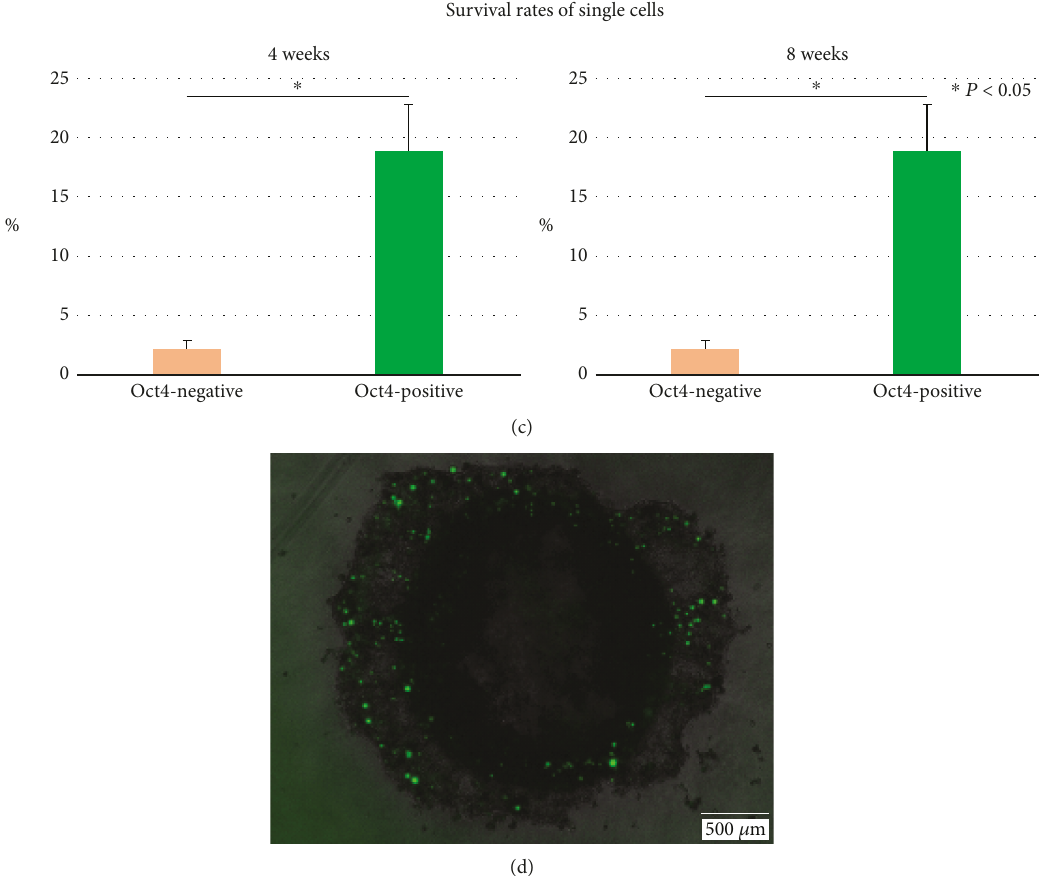
Figure 3: Growth of single sorted Oct4-positive and Oct4-negative cells. (a – c) Representative growth of Oct4-positive and Oct4-negative cells. (a) Growth images of Oct4-positive and Oct4-negative cells. Cells were indicated by white dotted lines. Oct4-positive cells proliferated well compared with Oct4-negative cells. (b) Growth curves of Oct4-positive and Oct4-negative cells. The colony sizes of Oct4- positive and Oct4-negative cells were measured. Oct4-positive cells proliferated well compared with Oct4-negative cells ( n = 5 , P < 0 05 ). (c) Survival rates of single sorted Oct4-positive and Oct4-negative cells. The survival rates of Oct4-positive cells were high compared with those of Oct4-negative cells four and eight weeks later of the sorting ( n = 9 , P < 0 005 ). (d) Representative image of colony from a single sorted Oct4-positive cell. Oct4-negative cells were produced from Oct4-positive cells. Scale bar, 500 μ